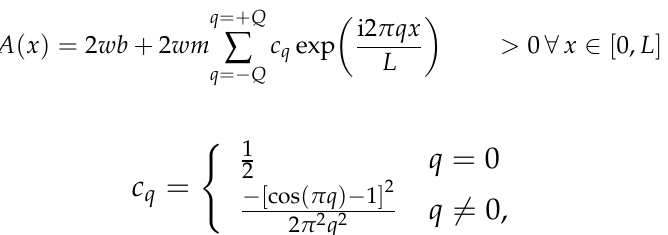
Figure 3. Convergence of the longitudinal displacement versus total number of summation terms and frequency for rod with linear change of area expressed in a decibel scale.